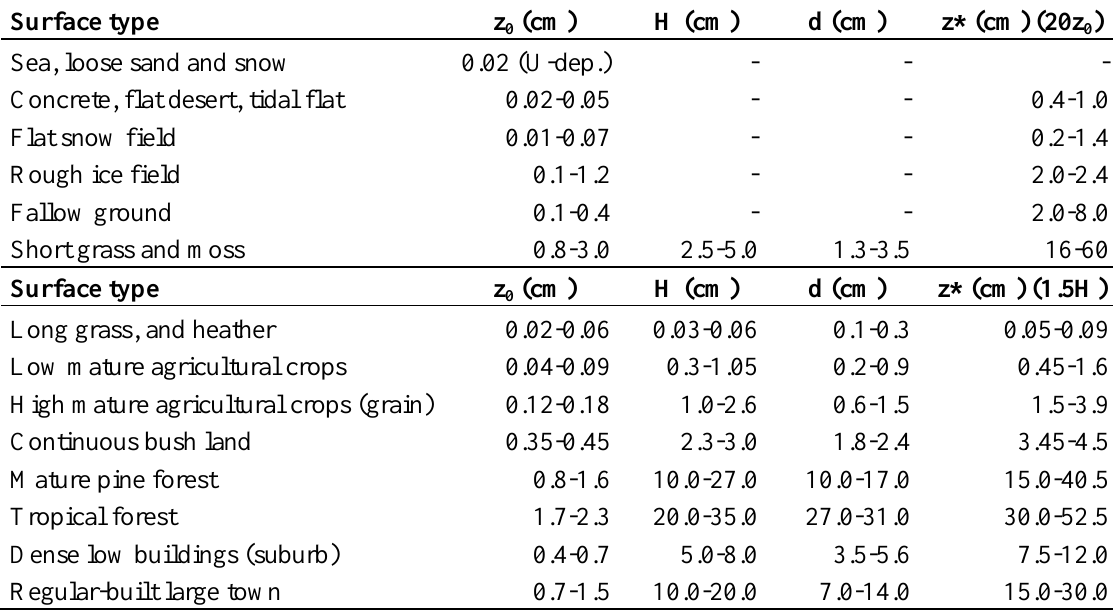
Table 1. Roughness parameters for homogeneous terrain classes